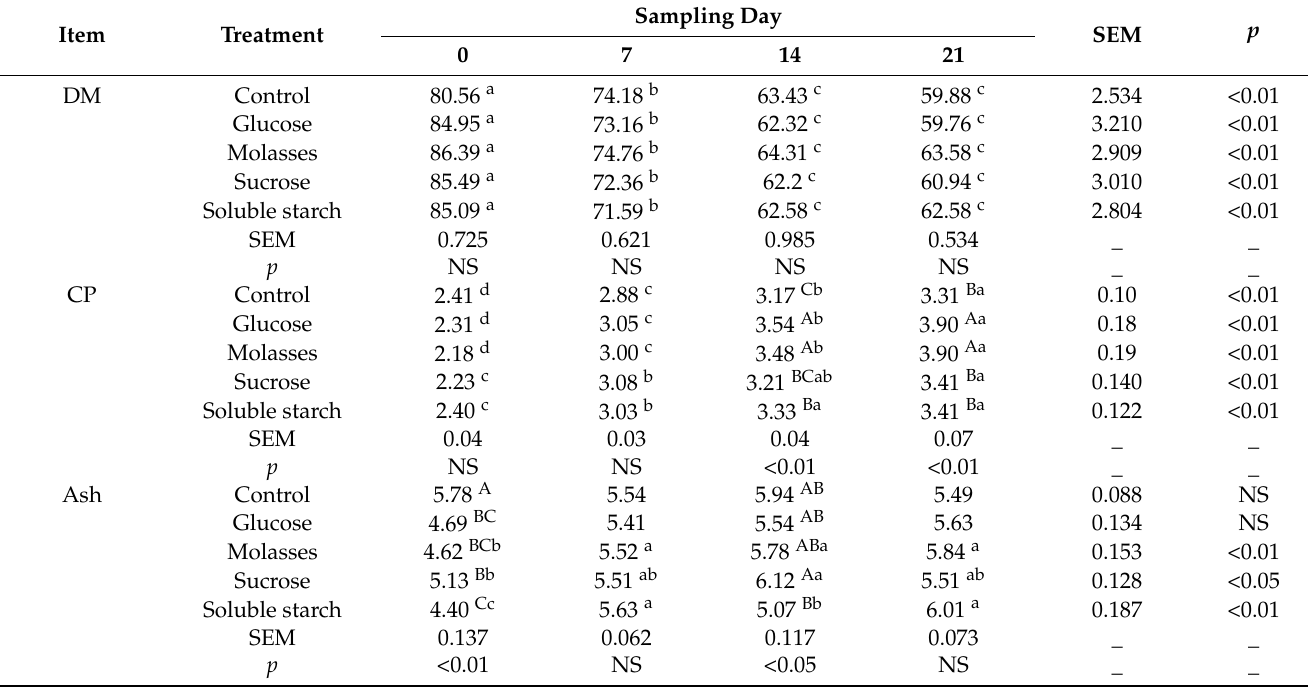
Table 1. Chemical composition of corn straw fermented by white rot fungi with the addition of different carbon sources (g/kg DM) after 0, 7, 14, and 21